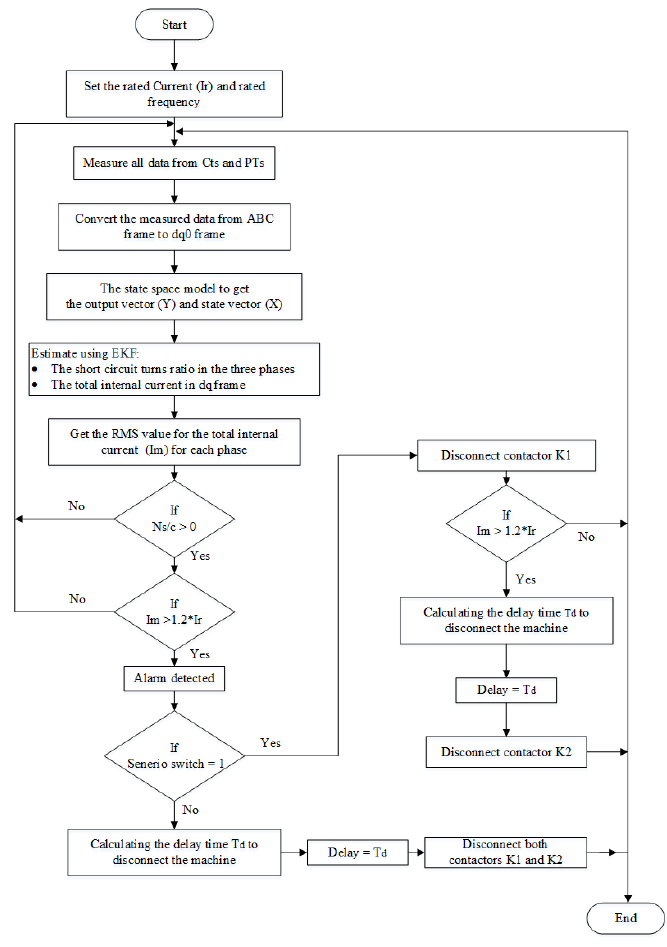
Figure 32. Decision-making process scenarios flowchart.